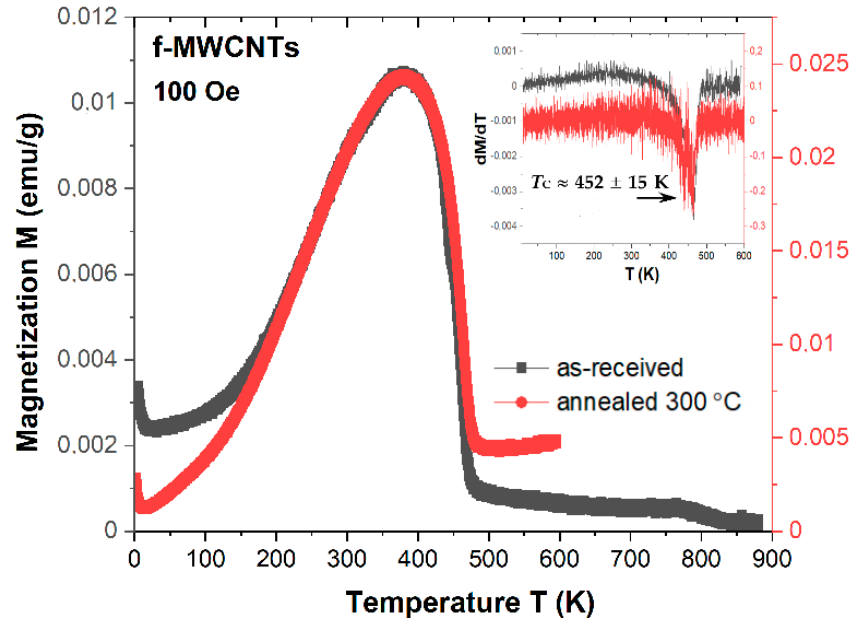
Figure 11. The ZFC dependence of magnetization M(T) measured at 100 Oe for f-MWCNTs and calcined at 300 °C. Inset shows the dM/dT vs. T dependence.